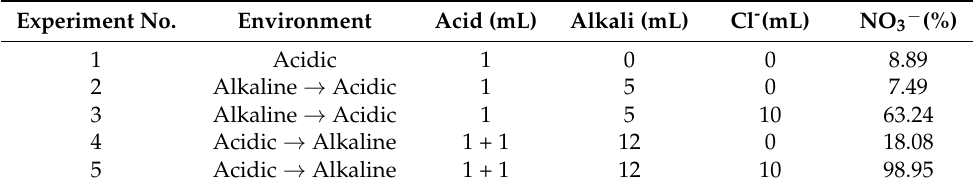
Table 1. Experimental scheme of Cl − interference in the digestion of glycine. Experiment